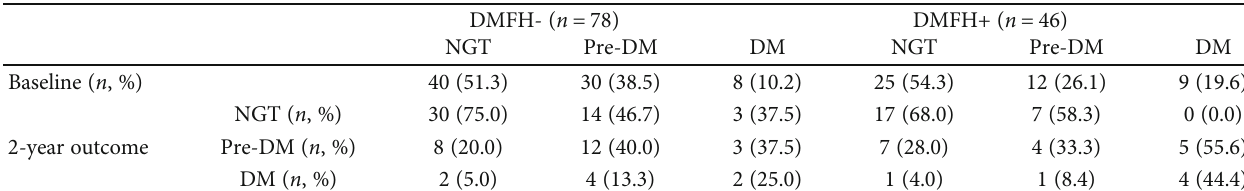
Table 3: Two-year glucose tolerance outcome in subjects with and without a family history of